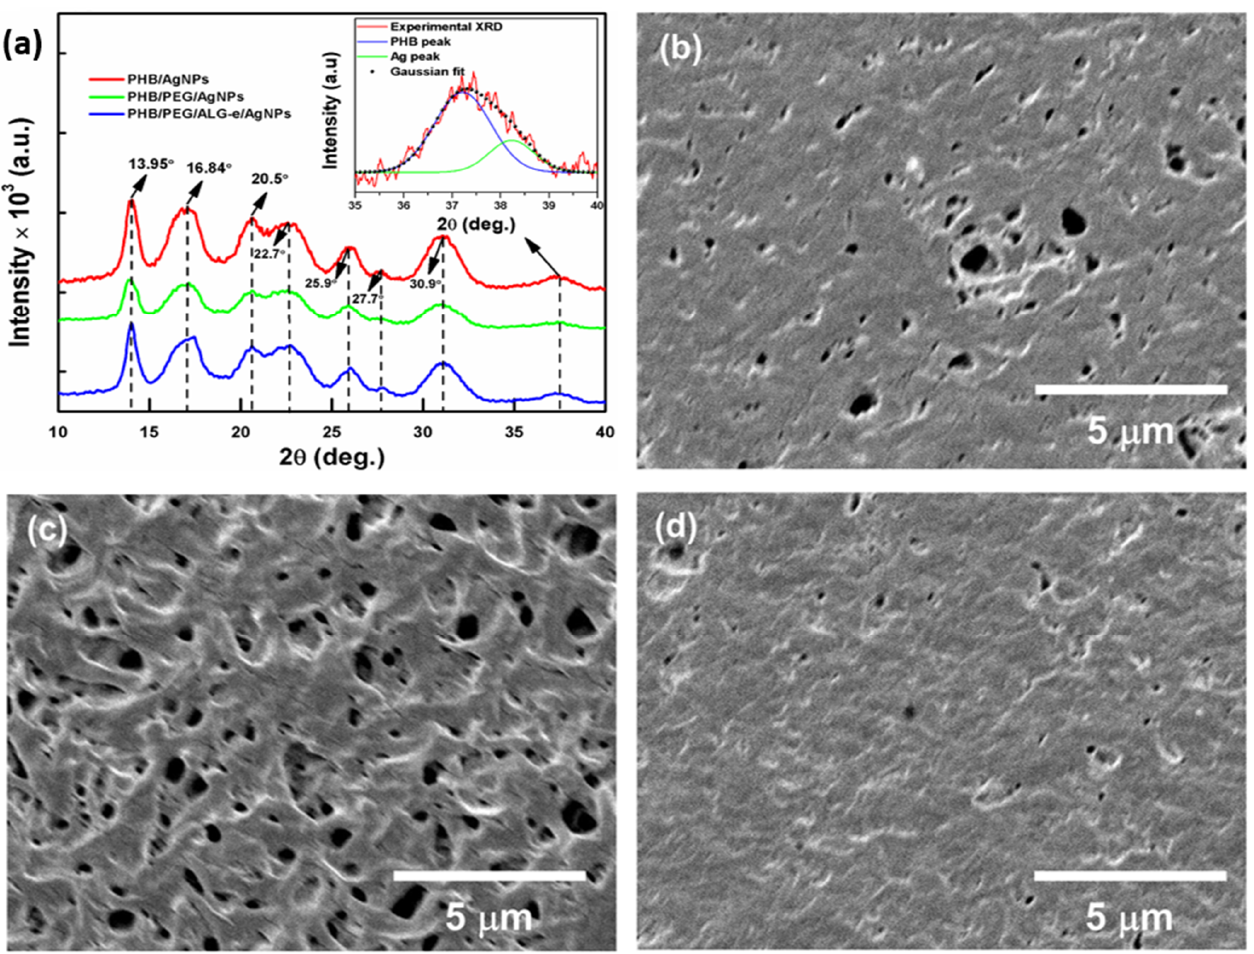
Figure 4. ( a ) XRD patterns and ( b – d ) SEM images of PHB/AgNPs, PHB/PEG/AgNPs, and PHB/PEG/ALG-e/AgNPs films, respectively. The plot inside panel ( a ) shows the deconvolution of the region comprising the superposition of PHB and Ag peaks in the range of 35–40°.